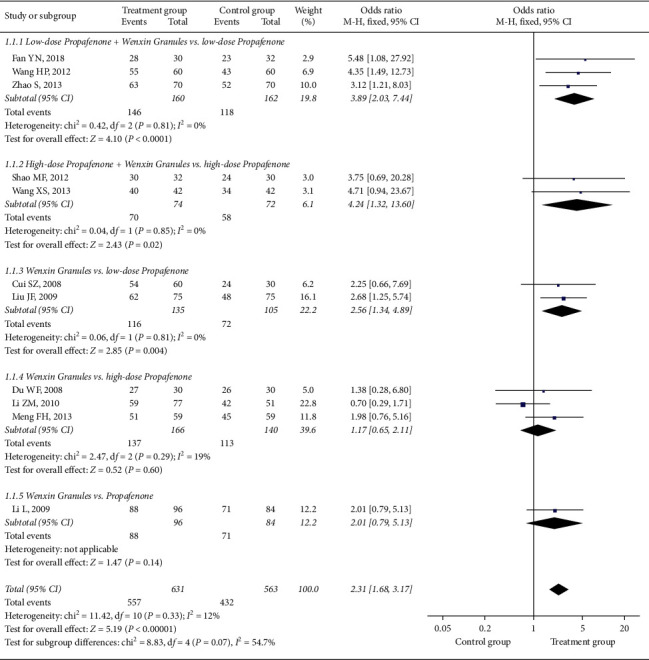
The forest plot of outcome measure clinical efficacy.